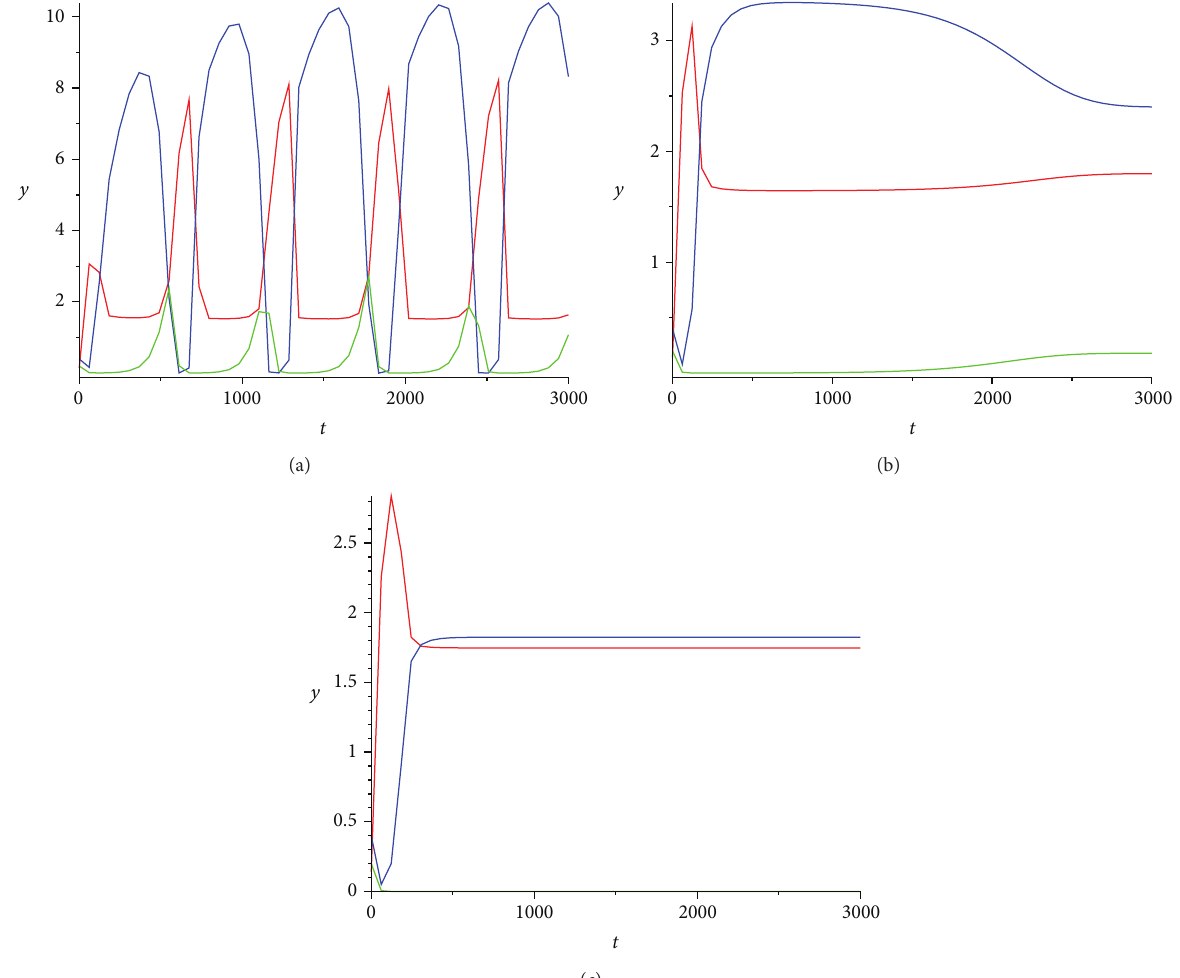
Figure 4: (a), (b), and (c) are time series of nutrient, phytoplankton, and zooplankton for 𝑑 = 0.0035, 0.01, 0.014 , respectively, where the thick line is the phytoplankton curve, the middle line is the nutrient curve, and the thin line is zooplankton curve.